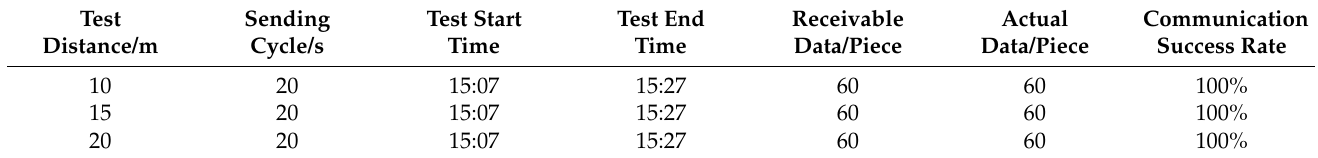
Table 9. Communication stability